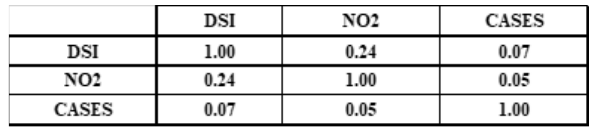
Table 1. Correlation matrix for the three parameters considered in this study.